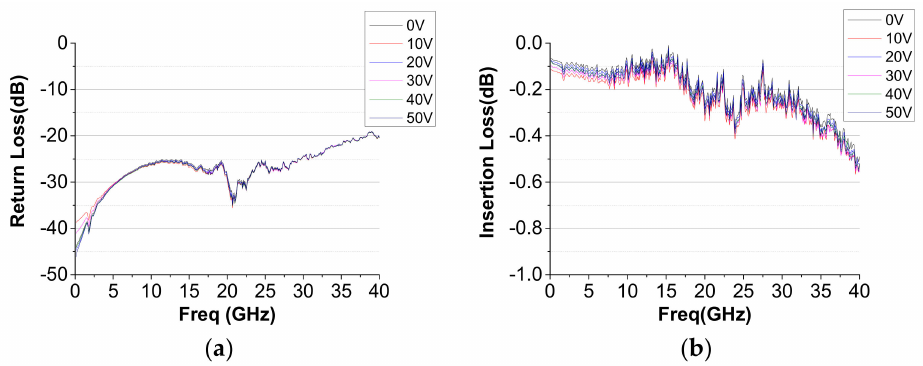
Figure 10. The measured result of PCM structure. ( a ) Return loss, ( b ) insertion loss.